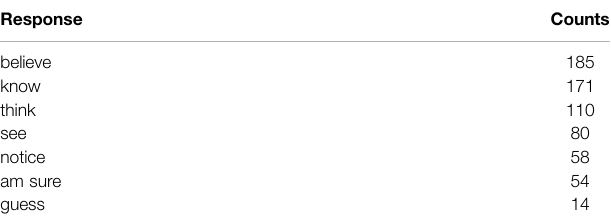
TABLE 1 | Raw counts for each utterance of the fi rst experiment ordered from most frequent to least frequent.